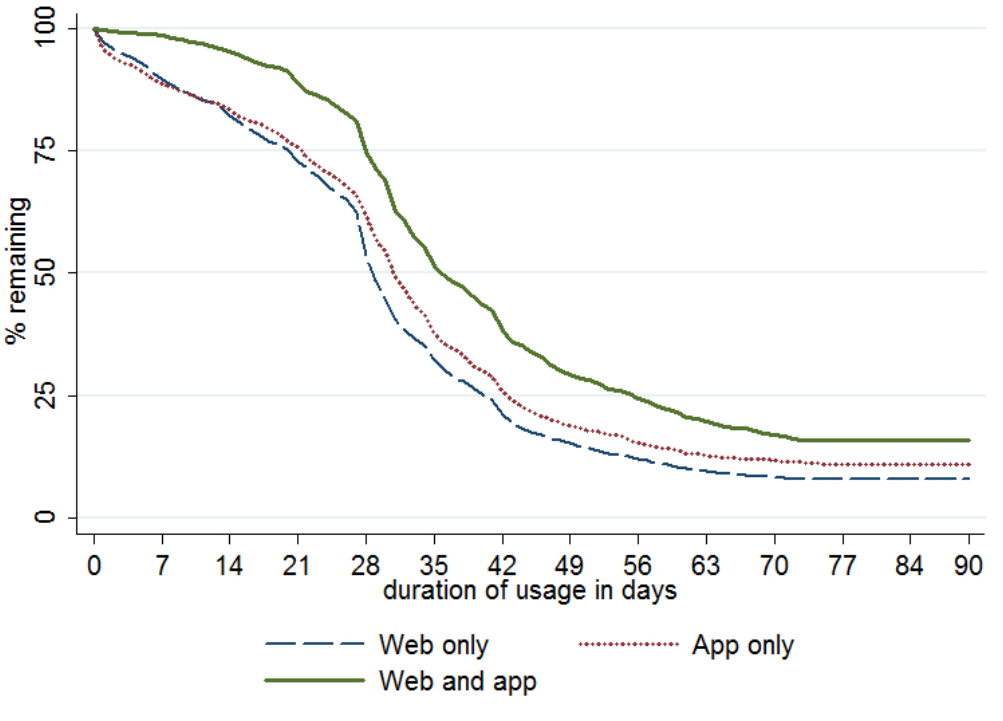
Figure 1. Nonusage attrition curves for user groups in the subsample of users who were 10,000 Steps members for at least 3 months